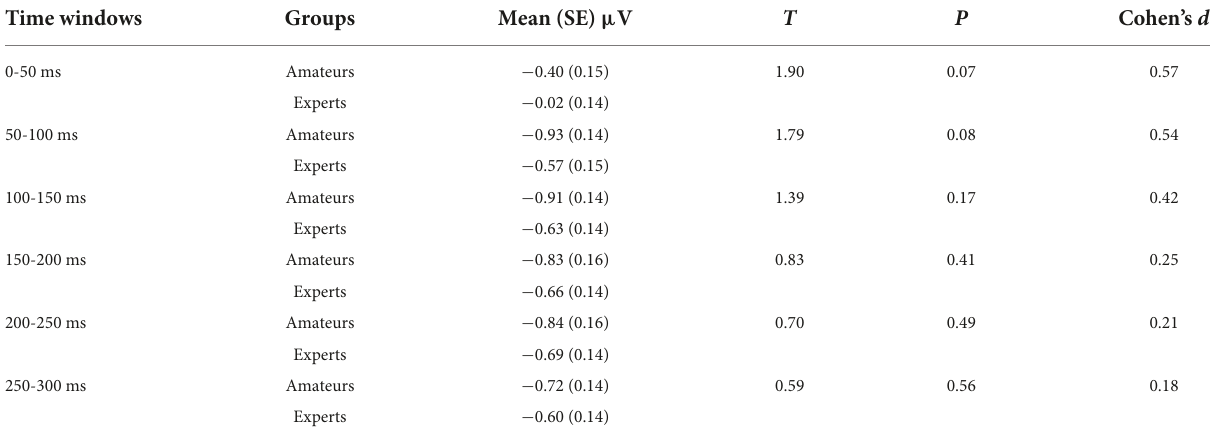
TABLE 3 The results of LRP-R component during 0-300 ms before